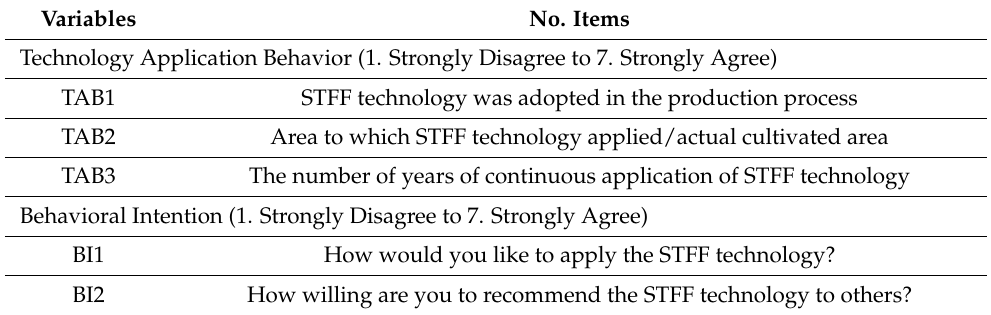
Table A1. Survey